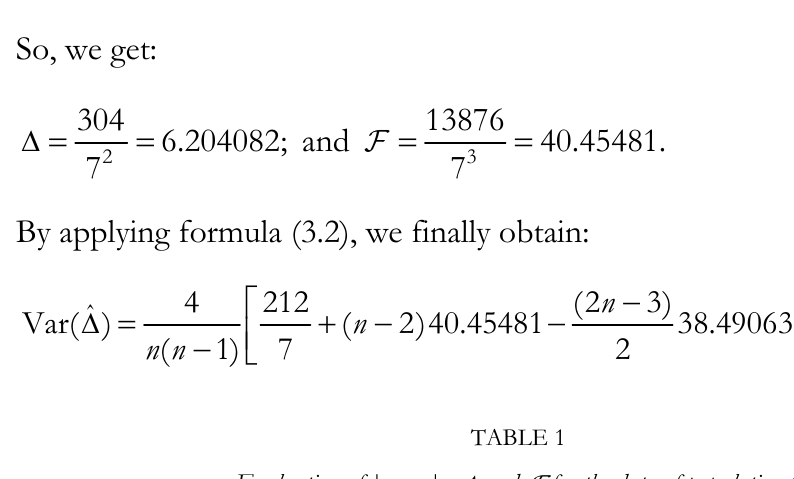
Evaluation of |a